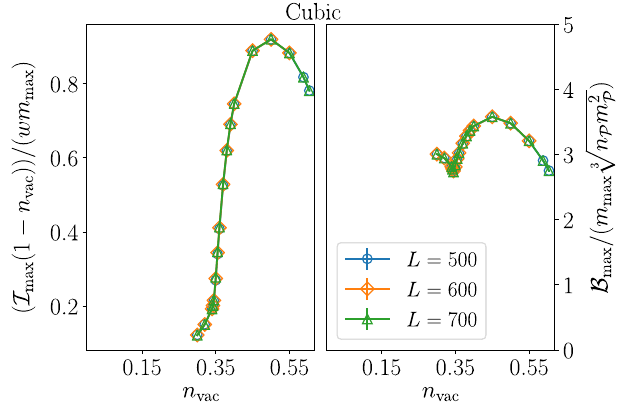
, the number of zero max